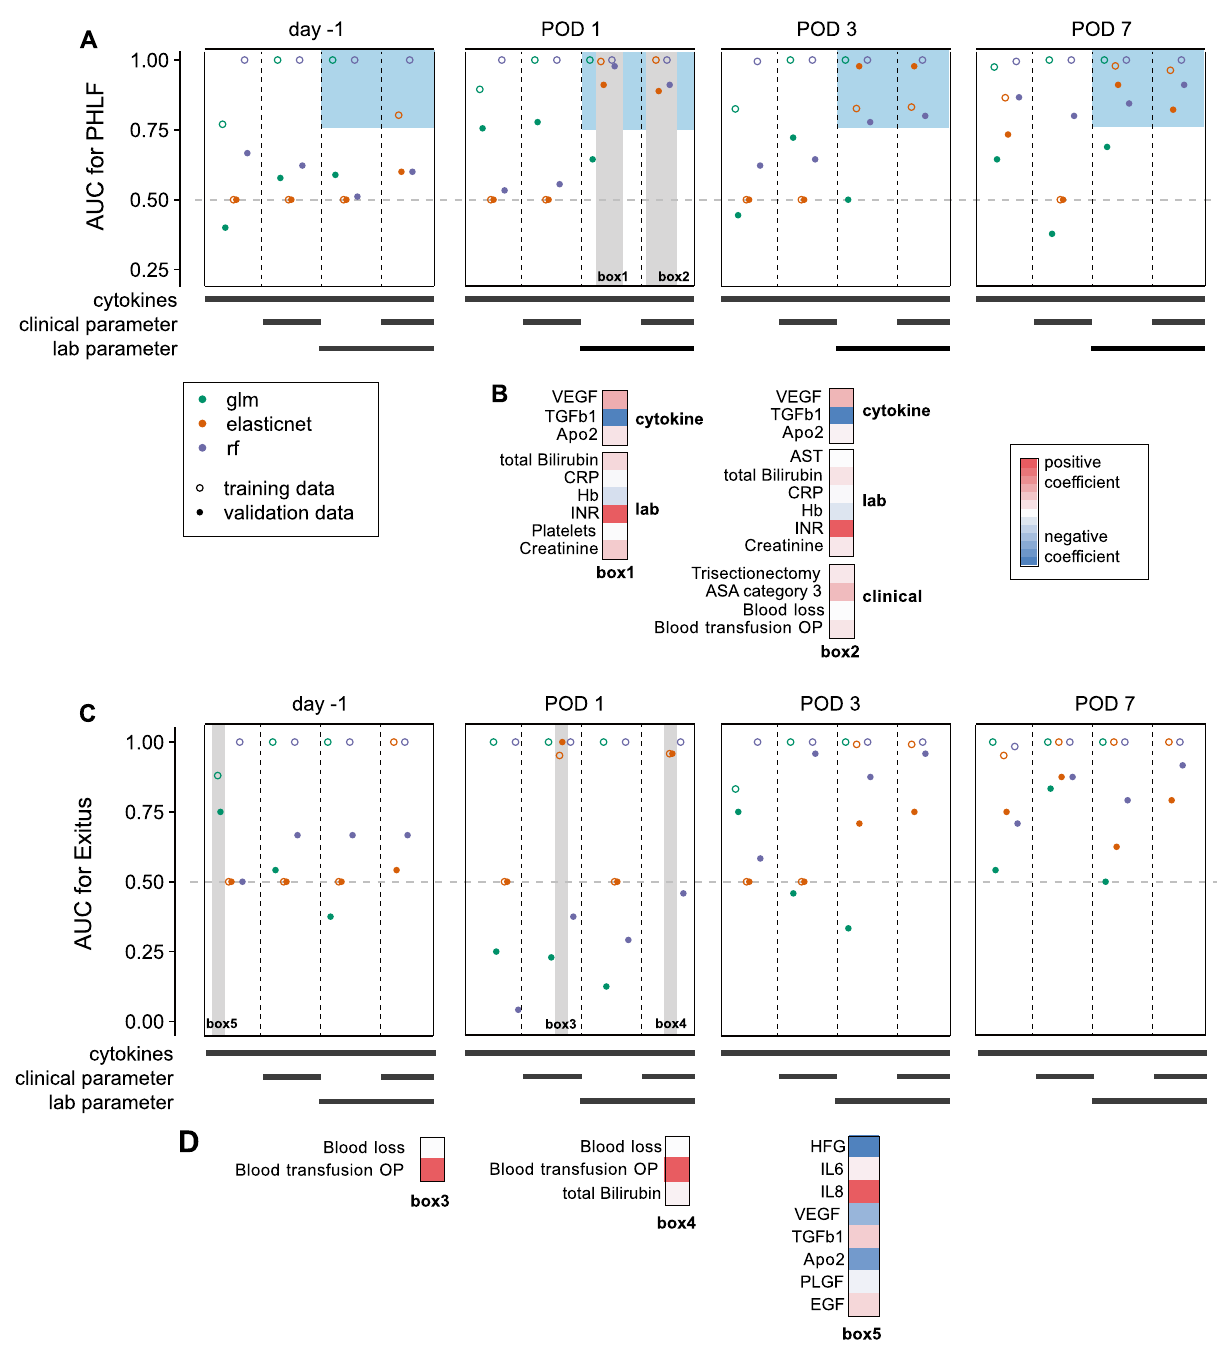
Figure 5. Predicting mortality and PHLF ( A ) AUC for predicting PHLF from different data sets. Data indicated on the x-axis consisted either of only cytokines, cytokine and clinical data, cytokine and routine lab data, or all three data. For each model, only data from one time point was used. Grey bars highlight AUC from training data (hollow dots) and validation data (solid dots blue box) from elastic net and random forest (orange and purple) close to 1 on POD 1. ( B ) Coefficients of the non-zero coefficients of the elastic net models in grey boxes 1 and 2 are displayed, color-coded by the respective positive or negative estimate. ( C ) AUC for predicting mortality from different data sets. Data indicated on the x-axis consisted either of only cytokines, cytokine and clinical data, cytokine and routine lab data, or all three data. For each model, only data from one time point was used. The validation AUC (solid shape) for some applied methods (highlighted with grey boxed) and some data sets (x-axis) is relatively close to 1 even for data from day -1 and POD 1. ( D ) Same as B for boxes 3, 4 and